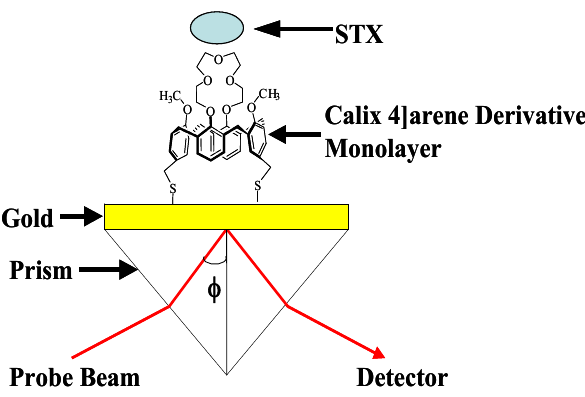
Figure 3. Schematic diagram of the sensor chip configuration.